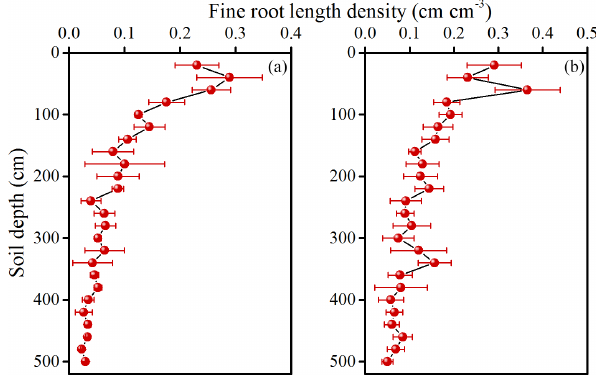
Figure 3. Vertical distribution of fine root length density (FRLD) in 11-year-old (a) and 17-year-old (b) apple orchards. Values are means ± SD ( N = 3).